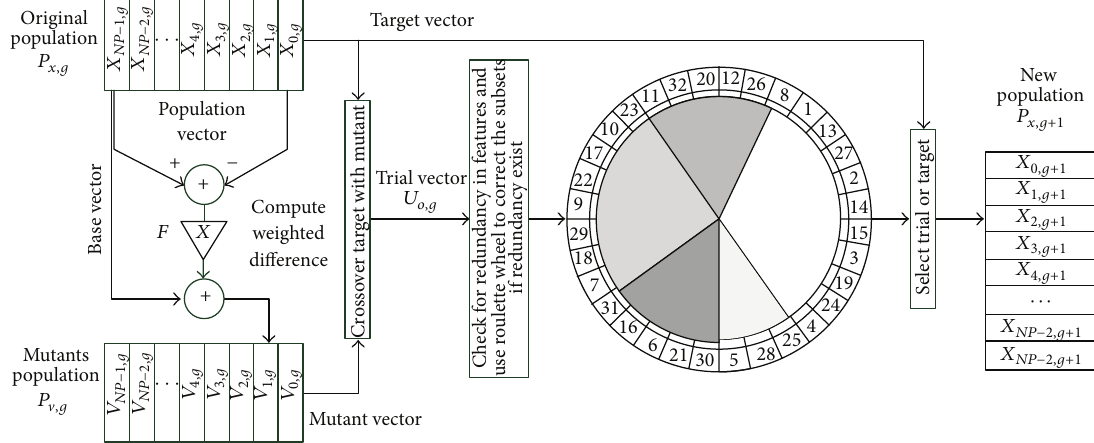
Figure 5: Flow diagram of the proposed steady-state GA.